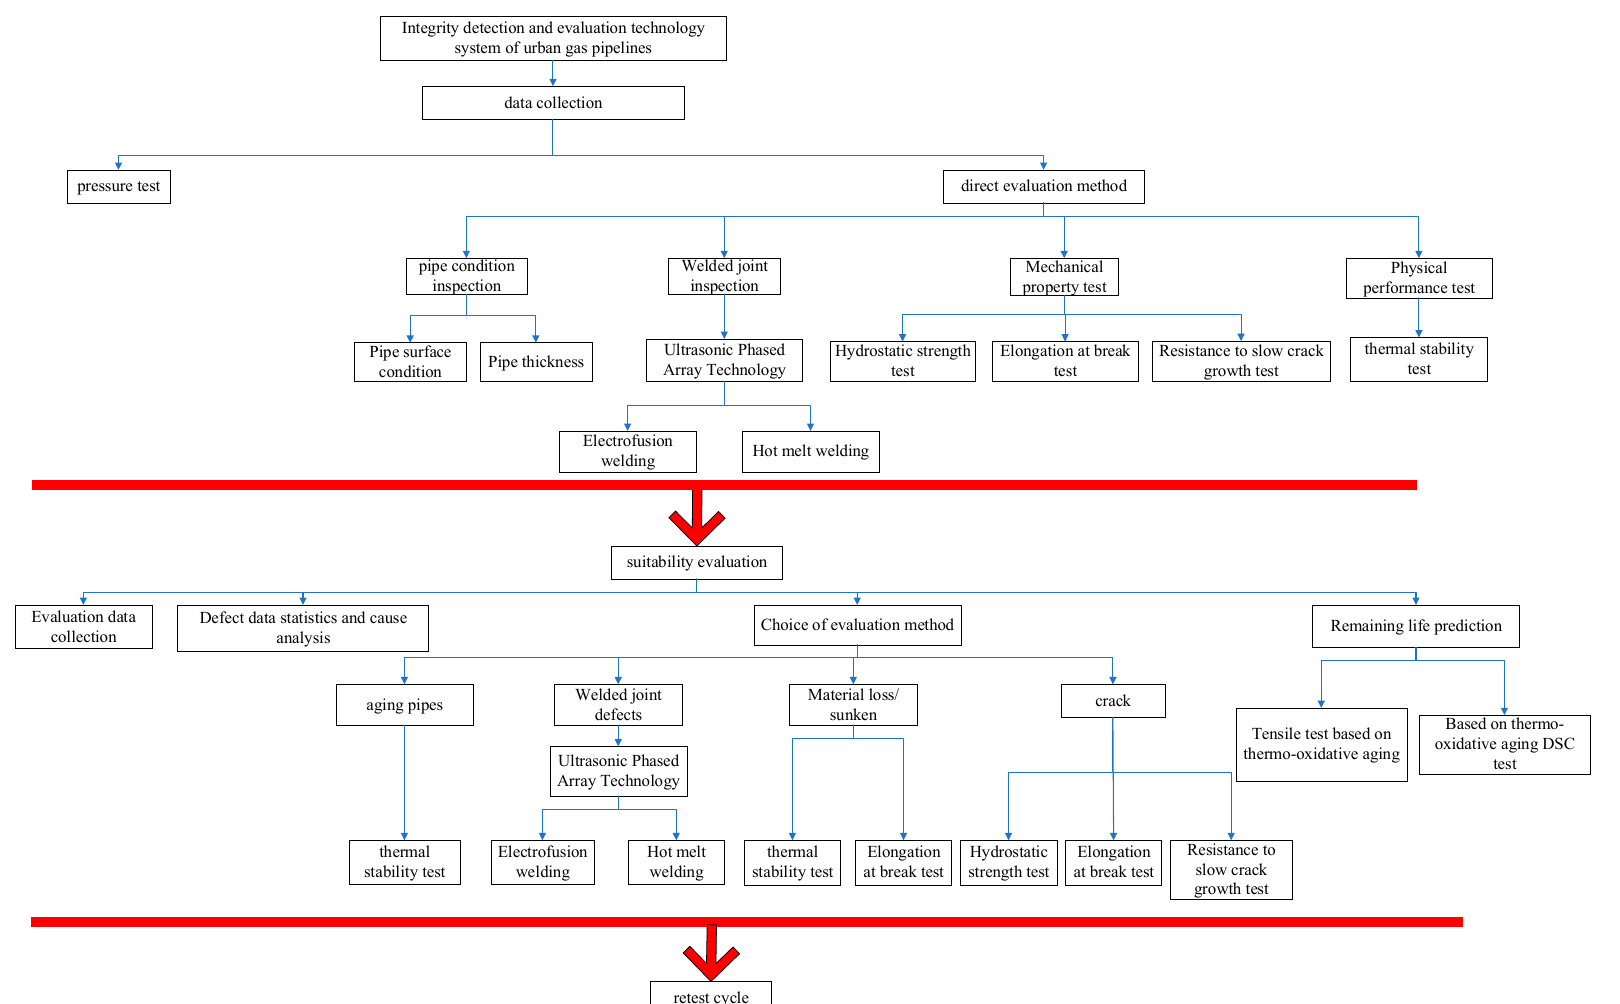
Figure 7. Framework diagram of the technical system for integrity detection and evaluation of urban gas pipelines.